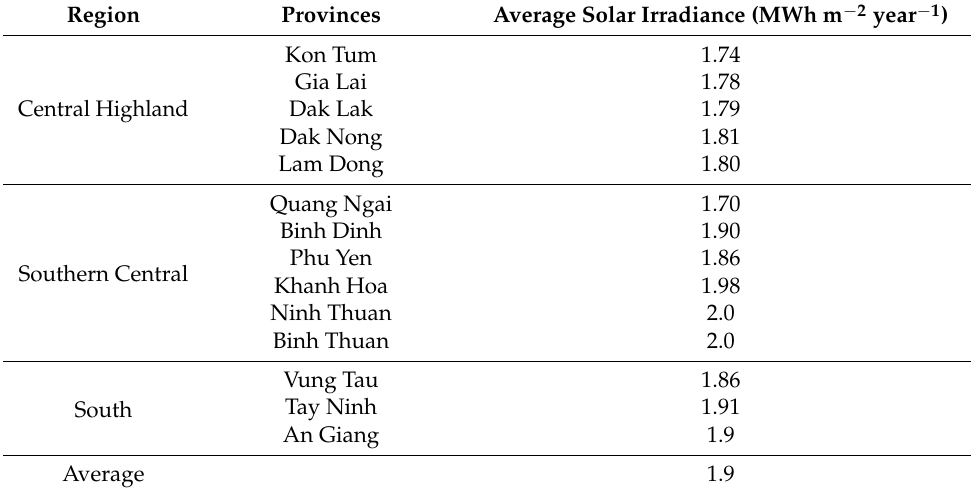
Table 1. Annual solar irradiance of some provinces in Vietnam. Reproduced from [30], The World Bank Group: